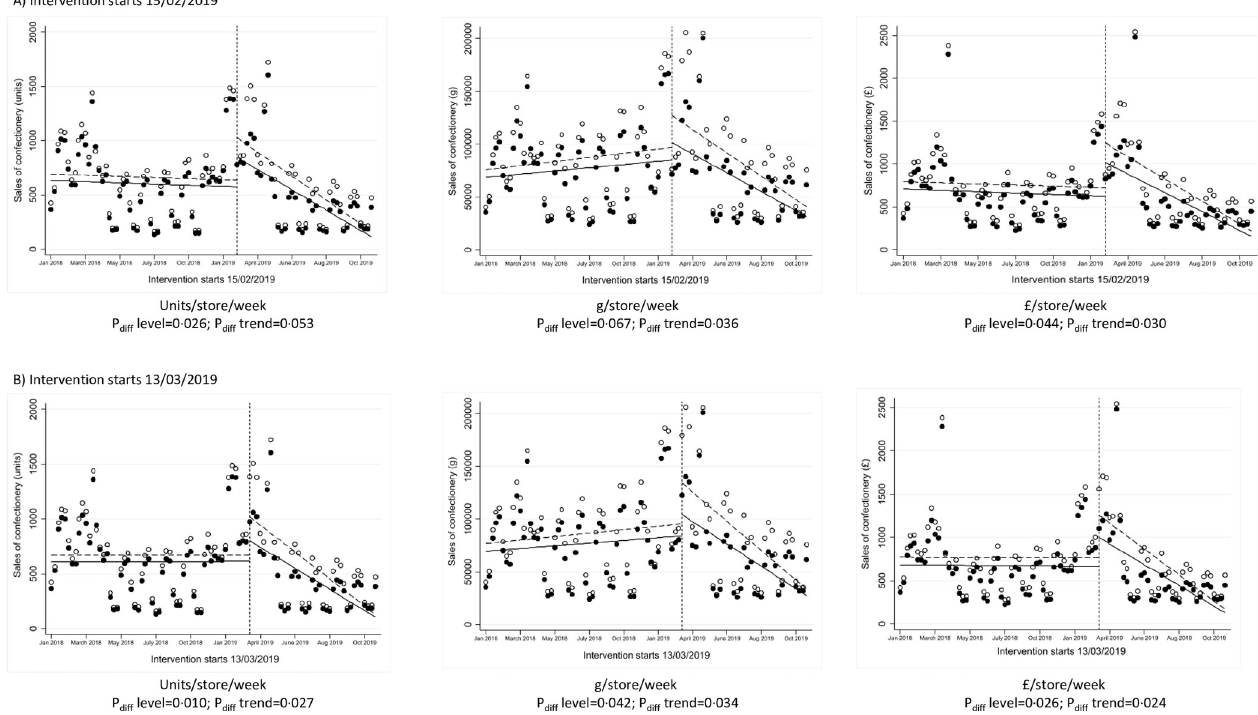
Fig 1. ITS analysis showing level and trend changes in weekly sales of confectionery. � Solid dots (observed) and lines (modelled) represent intervention stores; white dots (observed) and dotted lines (modelled) represent control stores. ITS, interrupted time series.